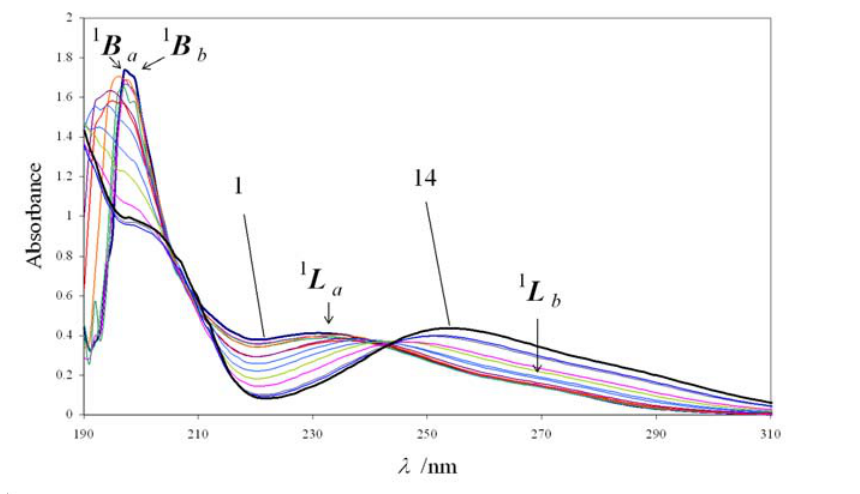
Fig. 1 Changes in the ultraviolet absorption spectra of o -benzotoluidide as a function of sulfuric acid concentration from 0.5 (curve 1) to 15.0 mol dm − 3 (curve